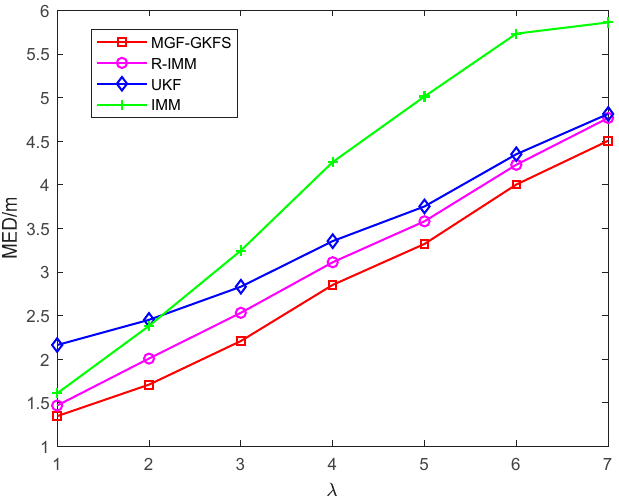
Figure 13. The MED versus the parameter λ .